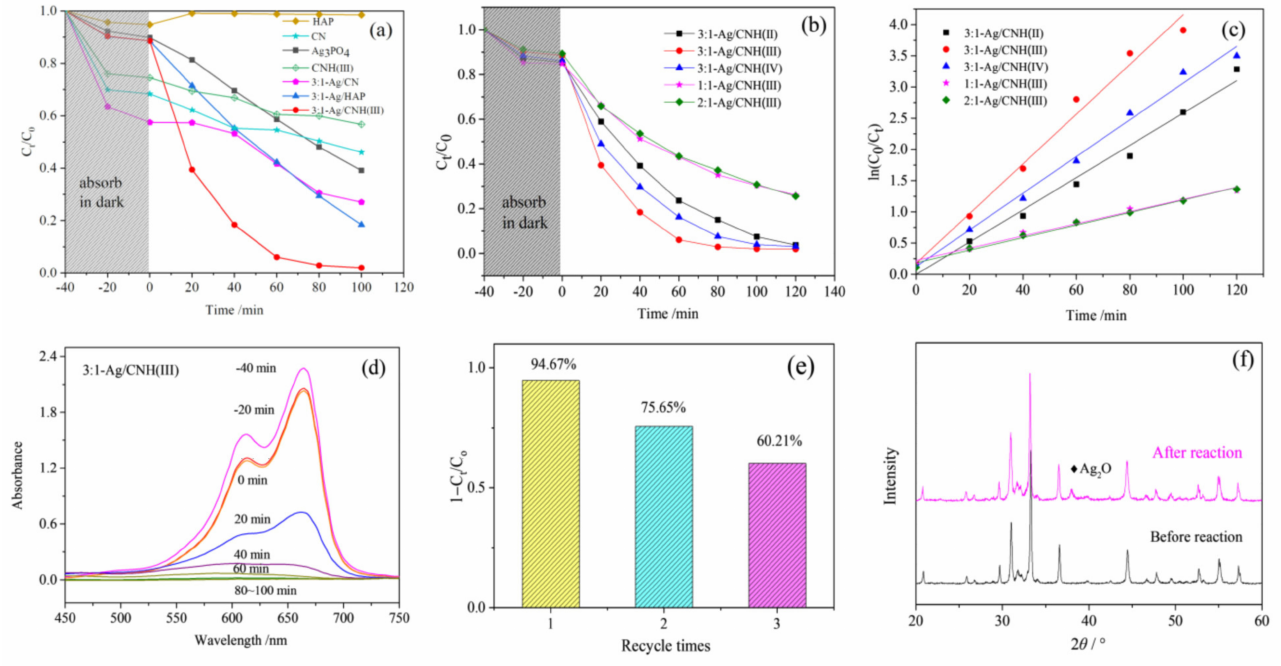
Figure 7. ( a , b ) Comparison of degradation MB curves over as-prepared photocatalysts; ( c ) photo- catalytic kinetics of different materials; ( d ) UV-VIS absorption spectrum of MB solution; ( e ) three cycling runs for degradation of MB over 3:1-Ag/CNH(III); ( f ) XRD patterns of the composite before and after